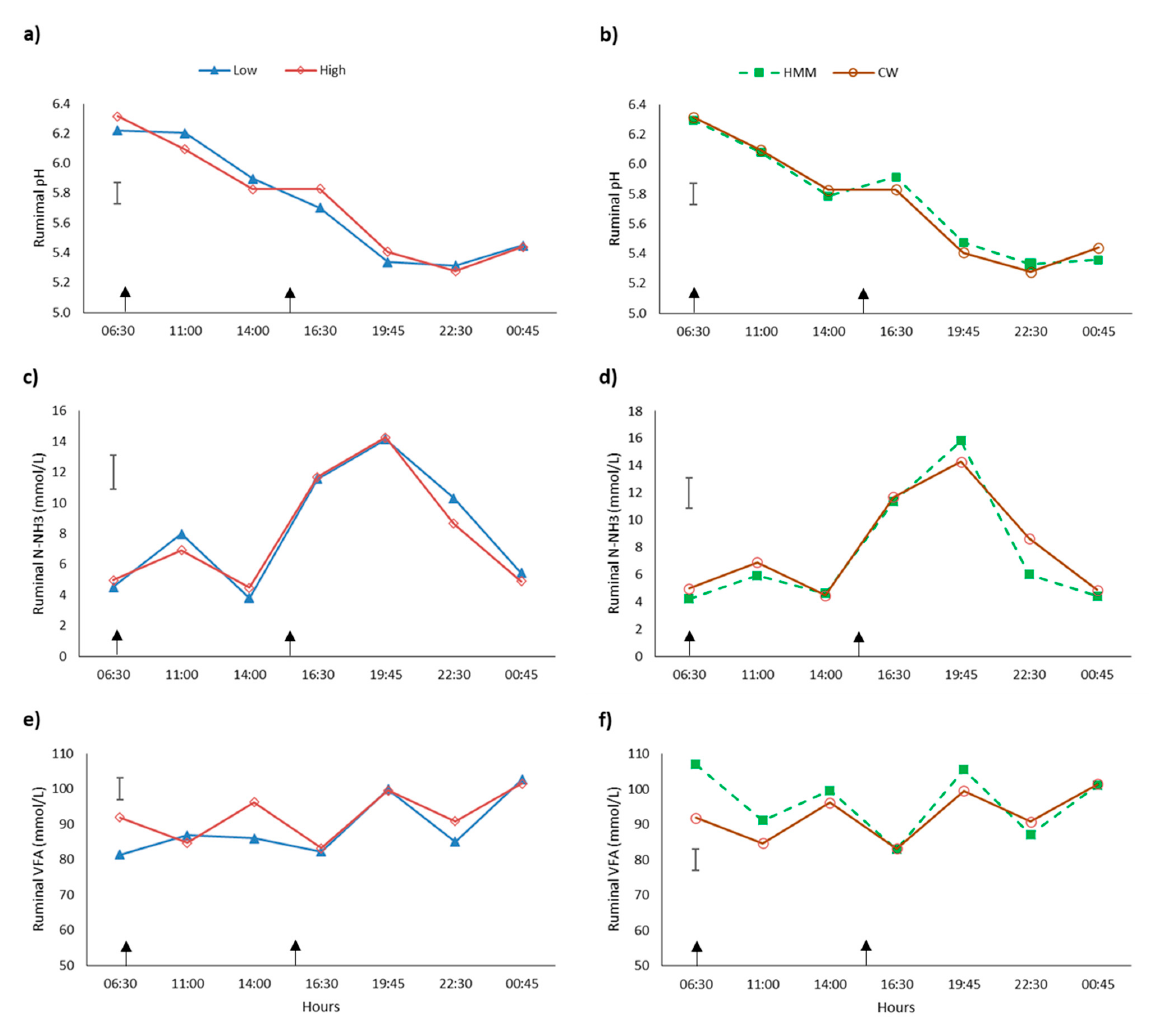
Figure 1. Diurnal variations of pH ( a , b ), NH 3 -N ( c , d ) and volatile fatty acids (VFA) ( e , f ) ruminal concentration in grazing dairy cows. Graphs ( a , c , e ) shows the two different herbage allowances; Low: 20 kg dry matter/cow/day ( ▲ ), or High: 30 dry matter/cow/day ( ♦ ). Graphs ( b , d , f ) shows the two different supplement types: high moisture maize HMM (O) or cracked wheat ( ■ ) (CW). Data are means drawn from four measurement periods ( n = 4). Vertical bars represent standard error of the means. Arrows represent supplementation time during milking (06:30 and 15:30 h).